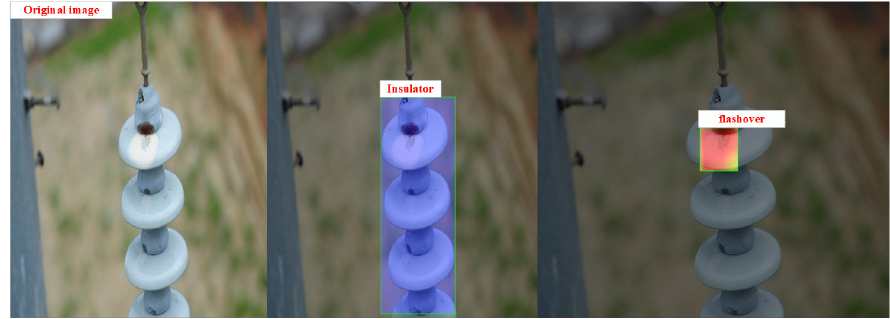
Figure 11. Grad-CAM visualizations for the original